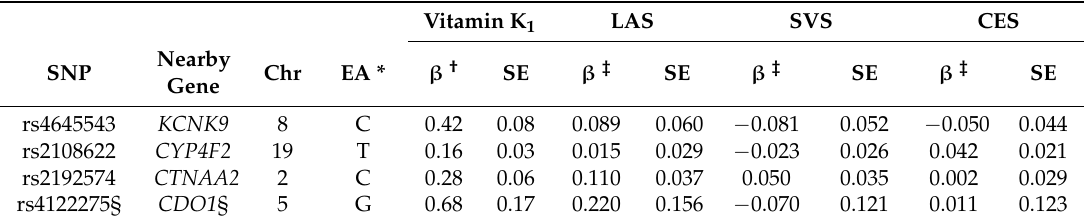
Table 1. Characteristics of the vitamin K 1 -associated single-nucleotide polymorphisms and their associations with ischemic stroke